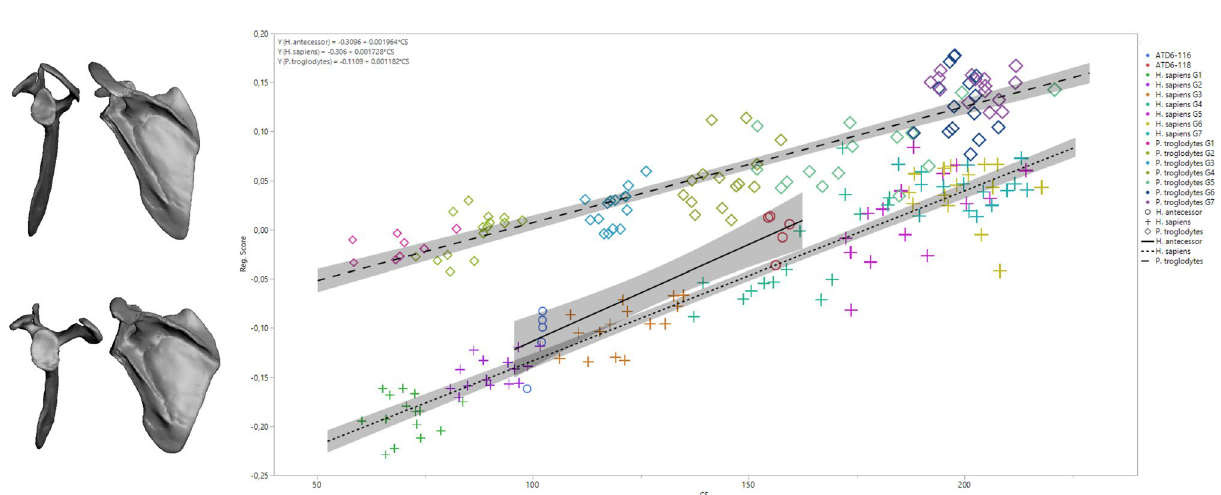
Figure 4. Regression analysis of full shape on size showing ontogenetic trajectories for H. sapiens (“+” symbols), P. troglodytes (“diamond” symbols), and H. antecessor (“circle” symbols). The regression formula and the confidence intervals are shown. Notice that for H. antecessor, all the acromion estimations are depicted (see “Materials and methods”). Different colors depict different age